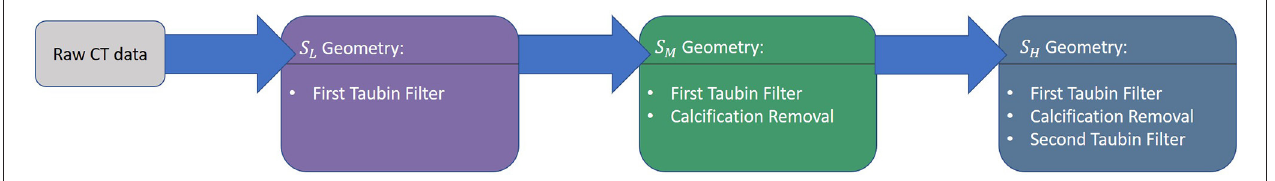
FIGURE 3 | Schematic of the cumulative smoothing strategy adopted for the aortic morphology.